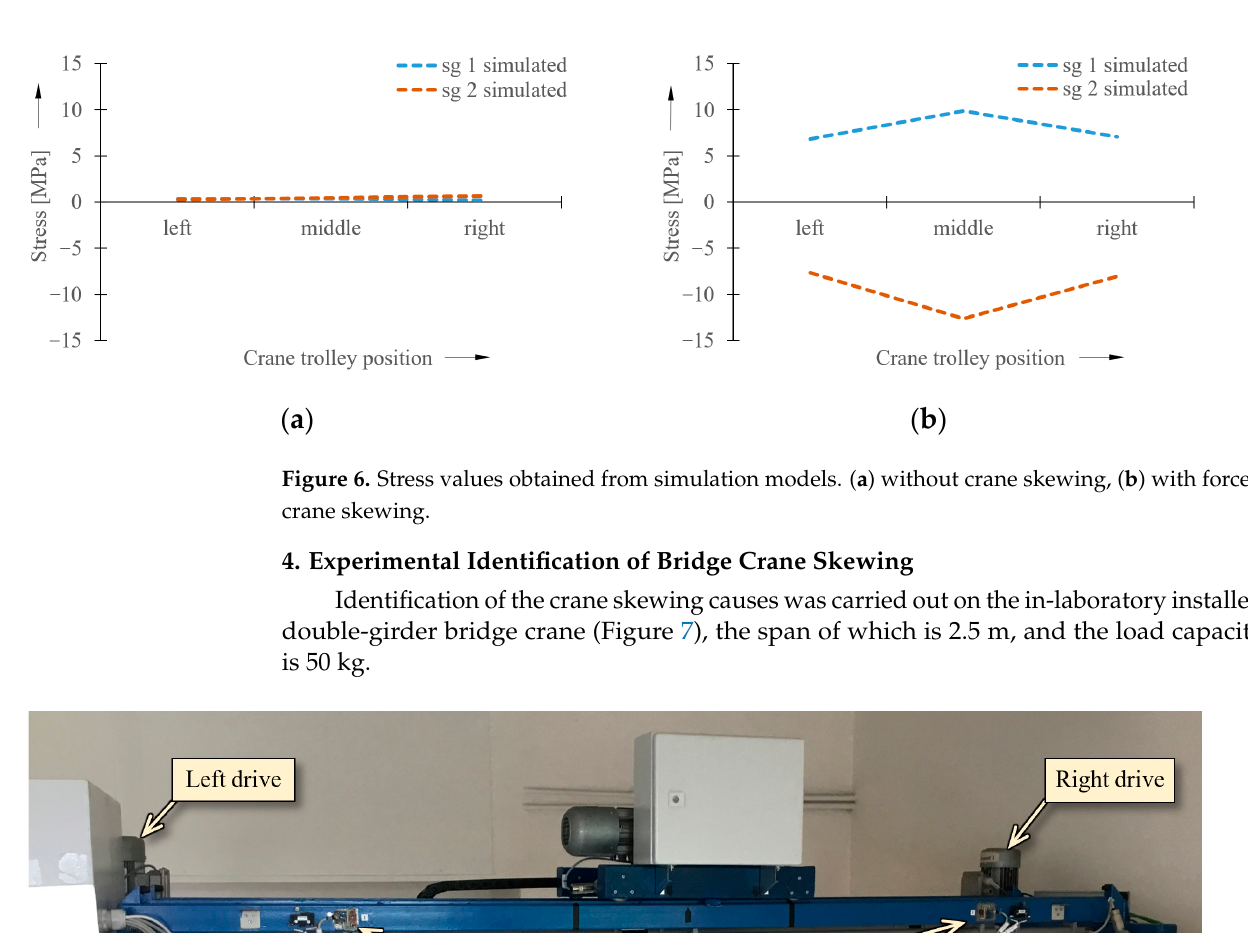
6 of 12 Figure 5. Placement of the strain gauge sensors on the crane bridge construction. Simulations of the crane’s operational states were performed under various opera- tional conditions and using various load cases. This article presents analyses of the crane bridge when traveling without crane skewing and with forced crane skewing. In both cases, the used load with a weight of 50 kg was in three different positions of its action.